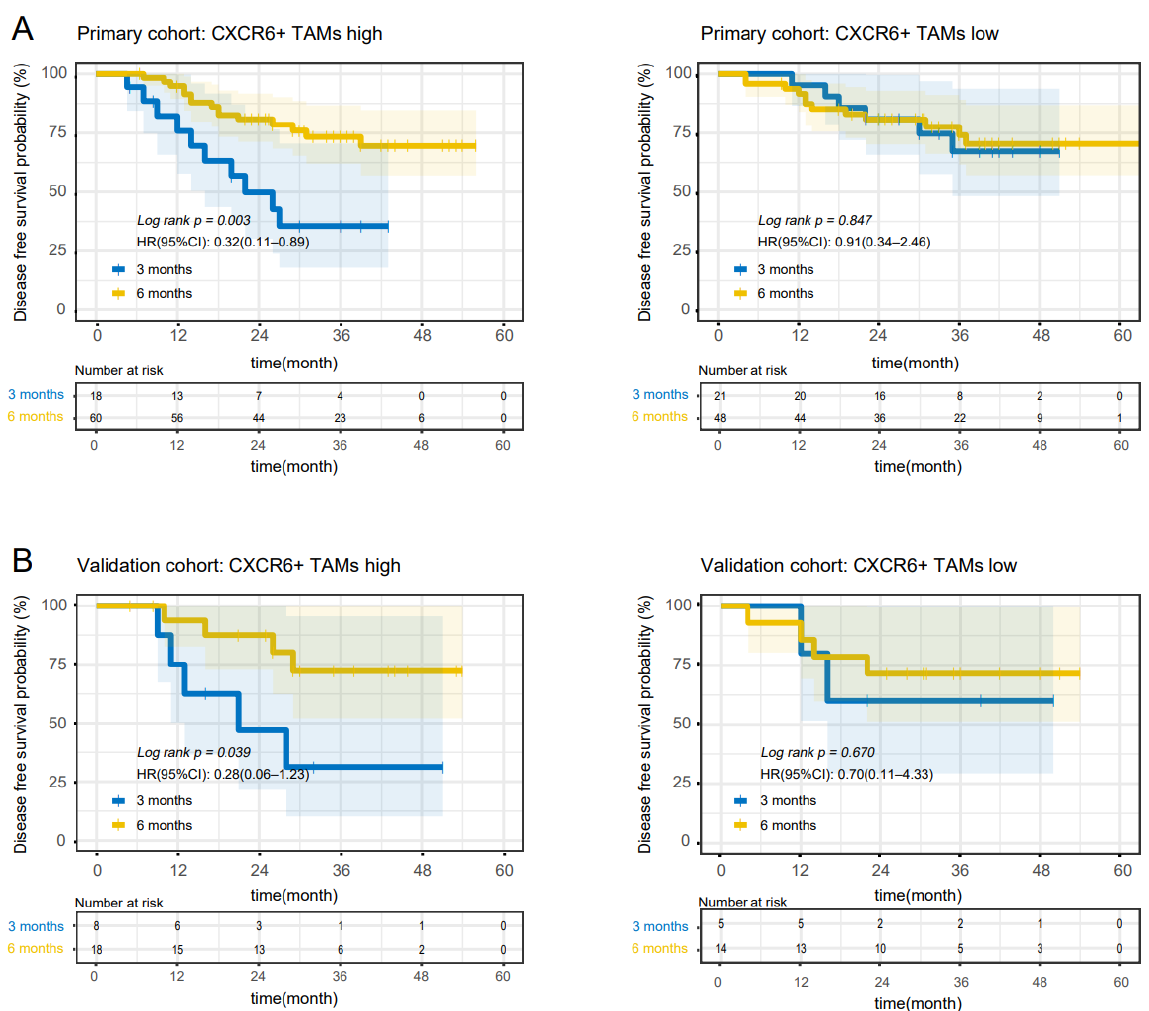
Figure 2. High CXCR6+ TAM infiltration is associated with a better response to 6-month adjuvant chemotherapy in high-risk stage II and stage III CC patients. ( A ) Disease-free survival curves of patients with high and low CXCR6+ TAMs from the primary cohort. ( B ) Disease-free survival curves of patients with high and low CXCR6+ TAMs from the validation cohort.